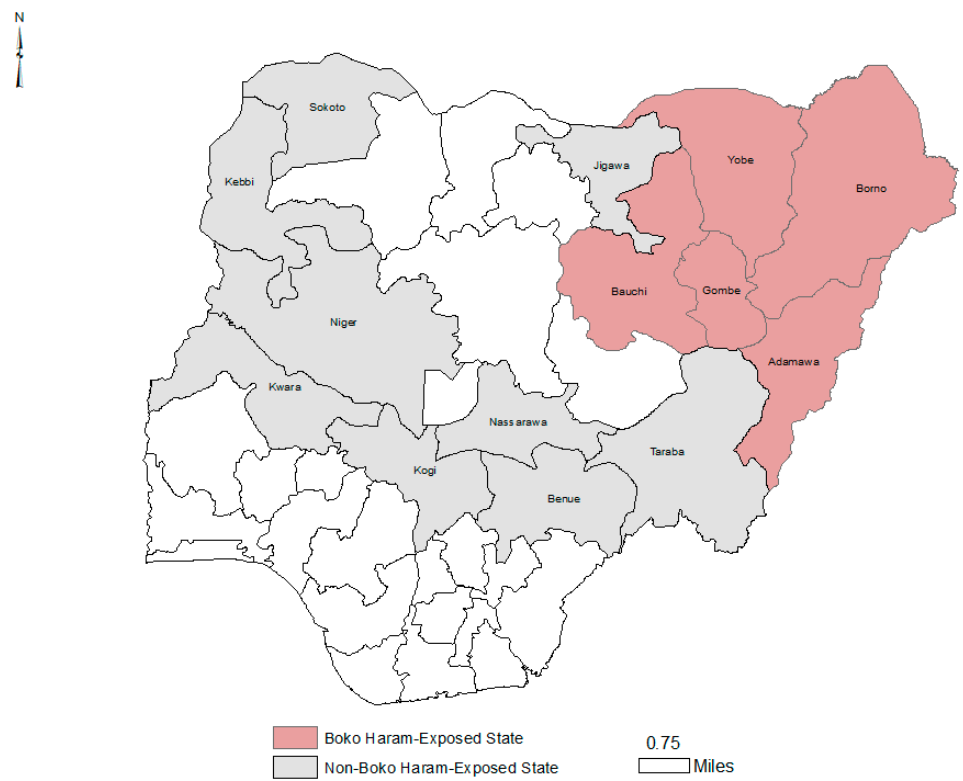
Figure 2. Study and control states. (Map generated using ArcGIS 10.7 software).